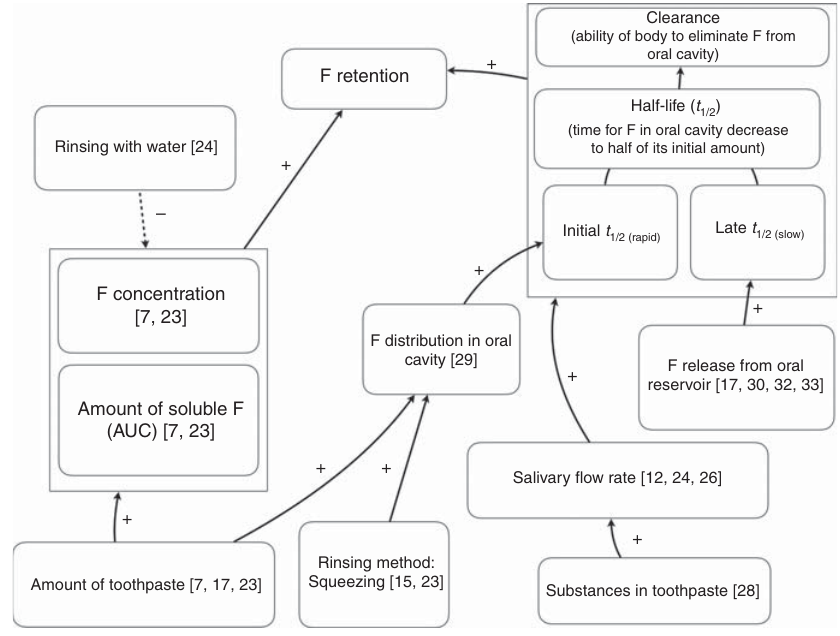
Figure 4. Factors